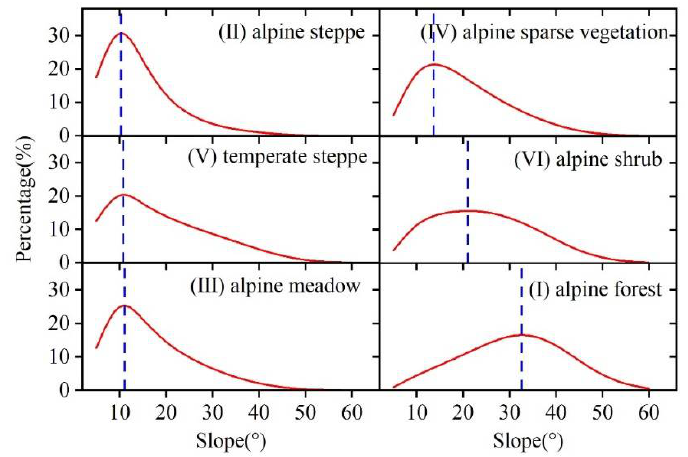
Figure 8. The proportion of pixels in each slope interval for six different vegetation types. The codes used for the vegetation types are the same as those in Figure